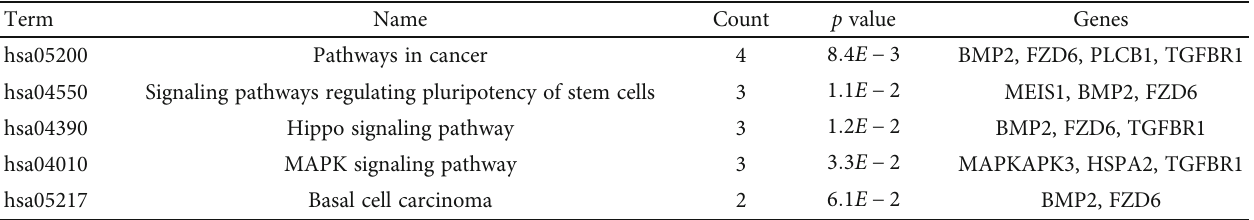
Table 2: Pathway enrichment analysis of the DEGs. Top 5 KEGG pathways were selected according to p